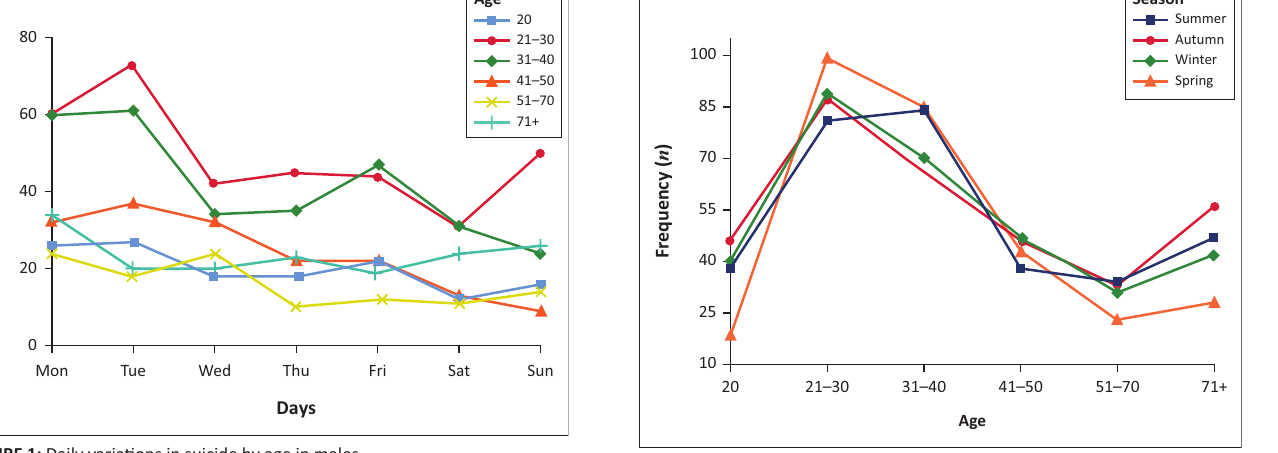
FIGURE 3 : Seasonal variation in suicide by age in males.